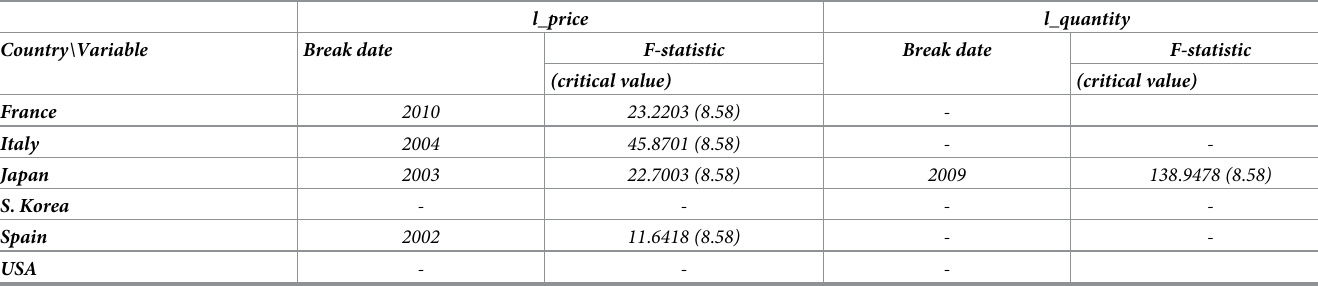
Table 4. Bai-Perron structural break test results for each variable and country.